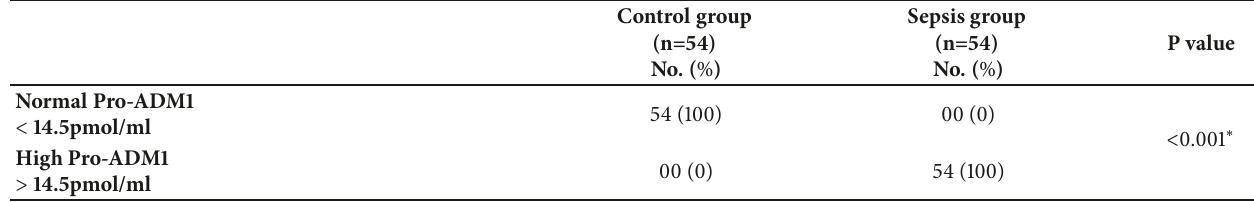
Table 2: Comparison of Pro-ADM1 among sepsis group and control with the cut-off level of 14.5pmol/ml.